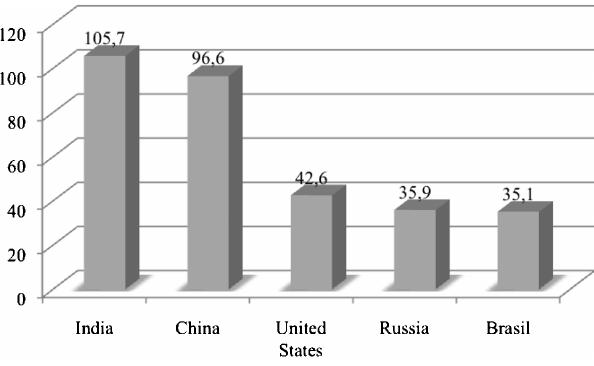
Figure 1 - Absolute number of deaths in motorvehicle accidents according to the World